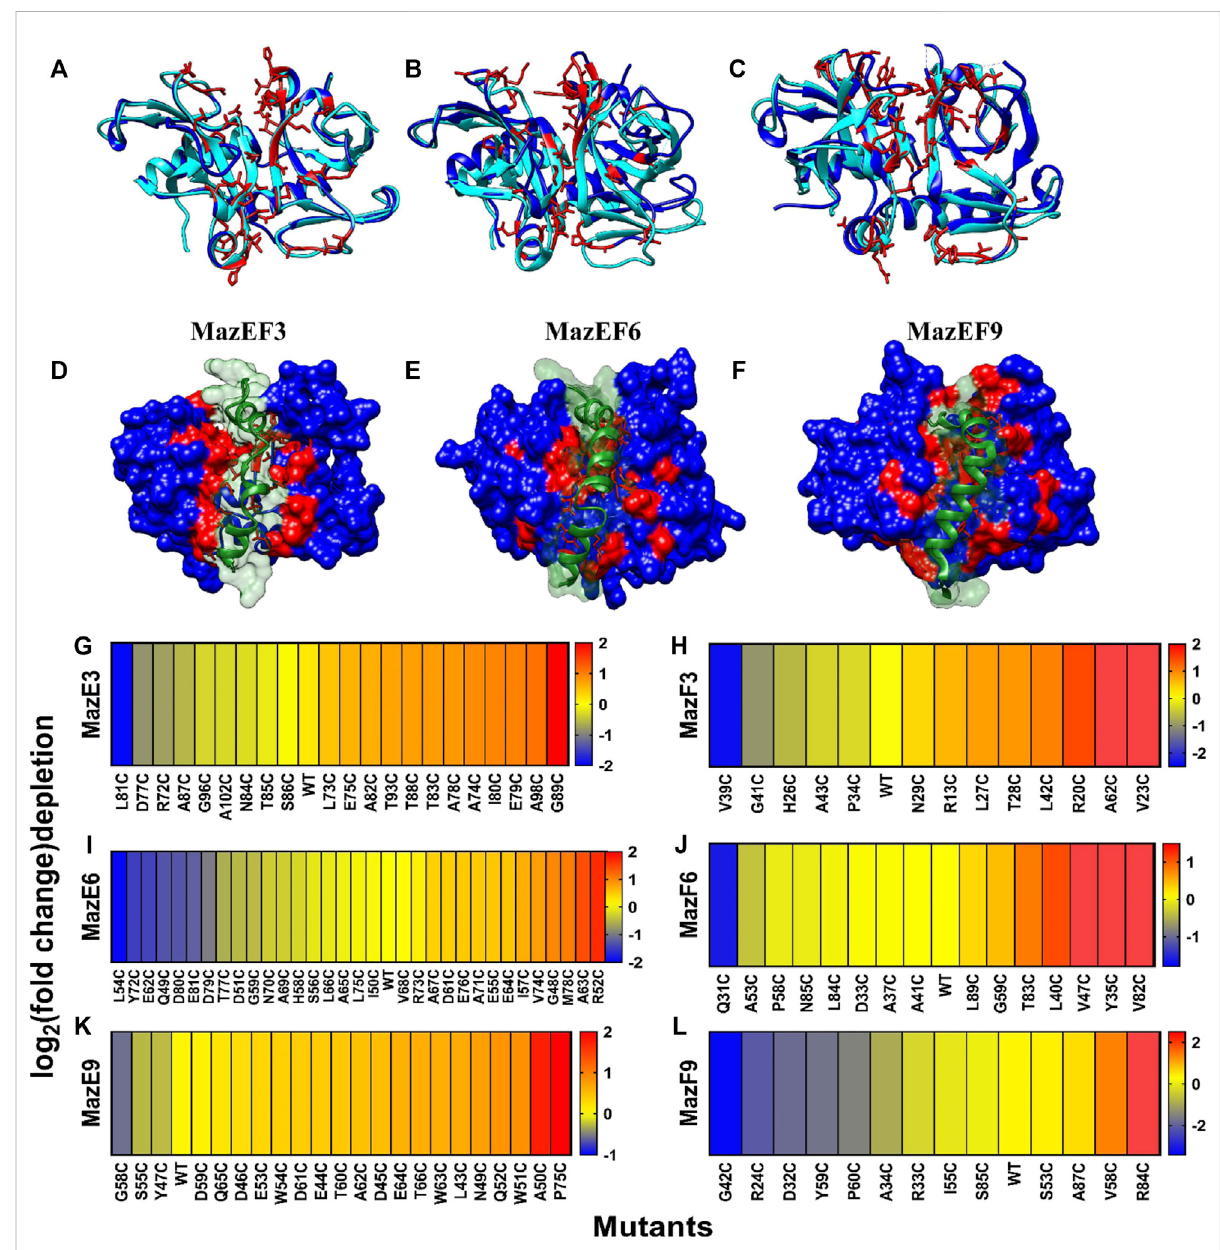
FIGURE 4 Heat map of fold change of binding after labeling in MazE and MazF libraries from 1D sorts. (A – F) Overlay of MazF toxin from B. subtilis with the modelled structuresof MazF3, MazF6and MazF9 toxins. B. subtilis MazFis incyan colour (A) MazF3 (26%), (B) MazF6(38%) and (C) MazF9 (34%)have moderate (%) sequence identity with the B. subtilis MazF and are shown in blue. The residues in the modelled toxins which were closest in space to the interacting residues of B. subtilis were predicted to be interacting with the cognate antitoxins, are shown in red and were chosen for experimental studies. The bottom panel shows the antitoxin in green which is modelled in complex with the cognate toxin shown in blue, using homology modelling by Modeller v9.14 for (D) MazEF3, (E) MazEF6 and (F) MazEF9 complexes. The predicted interface residues for the toxin are showninred.Heatmapsshowinglog 2 (fold-change)ofdepletionvaluesafterlabelingof (G) MazE3, (H) MazF3, (I) MazE6, (J) MazF6, (K) MazE9and (L) MazF9cysteinelibraries.Astringencyof100readsinallthegatescombinedwasusedasacut-offforfurtheranalysisofmutants.Thefold-changecut off for identi fi cation of the interacting residues, was determined by k means clustering. Blue to red represents increasing log 2 (fold change) of ) . Where, MFI Mutant (cid:2) MFI unlabeled depletion values after labeling which is de fi ned as log 2 ( MFI Mutant depletion . Red denotes positions where substitutions have the depletion MFI labeled MFI WT depletion maximum affect whereas yellow denotes the residues where there is no effect upon mutation, similar to WT. Blue denotes residues which show increased binding after